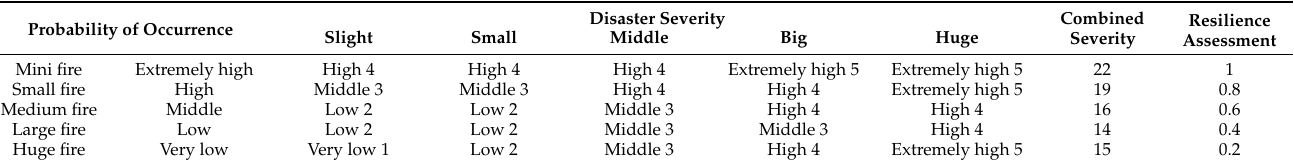
Table 5. Fire hazard risk assessment table.